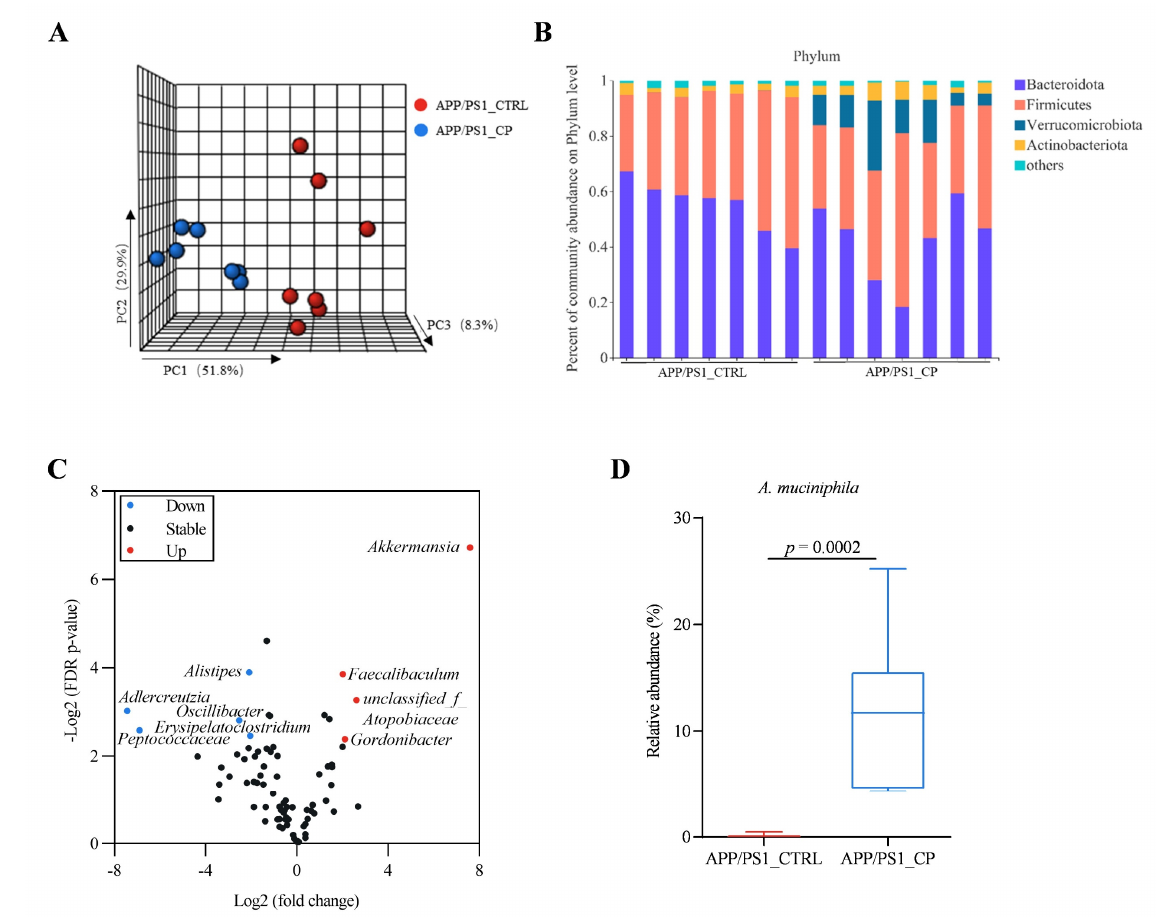
Figure 3. Relative abundance of gut microbiota in mice individuals (all groups: n = 7). ( A ) Bray– Curtis-based principal component analysis (PCA) plot of gut microbial communities in APP/PS1 mice. ( B ) Bar plot displaying changes in relative abundances at the phylum level in APP/PS1 mice treated with vehicle or capsaicin. ( C ) Volcano plot displaying differences in gut microbiota between APP/PS1_CTRL and APP/PS1_CP. ( D ) Comparison of the change in A. muciniphila between APP/PS1_CTRL and APP/PS1_CP. Results are mean ± SEM. The minimum significance value was considered as p < 0.05.